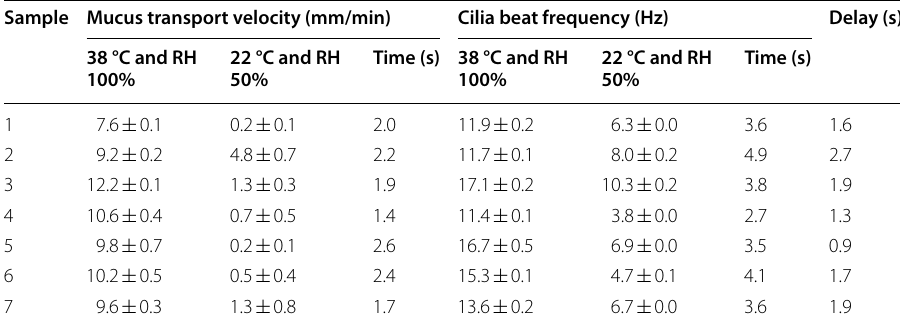
Table 1 Mean mucus transport velocity (MTV) and cilia beat frequency (CBF) measurements under body temperature and fully saturated with water vapor (38 °C and relative humidity (RH)100%) and room air (22 °C and RH 50%) from each analyzed video